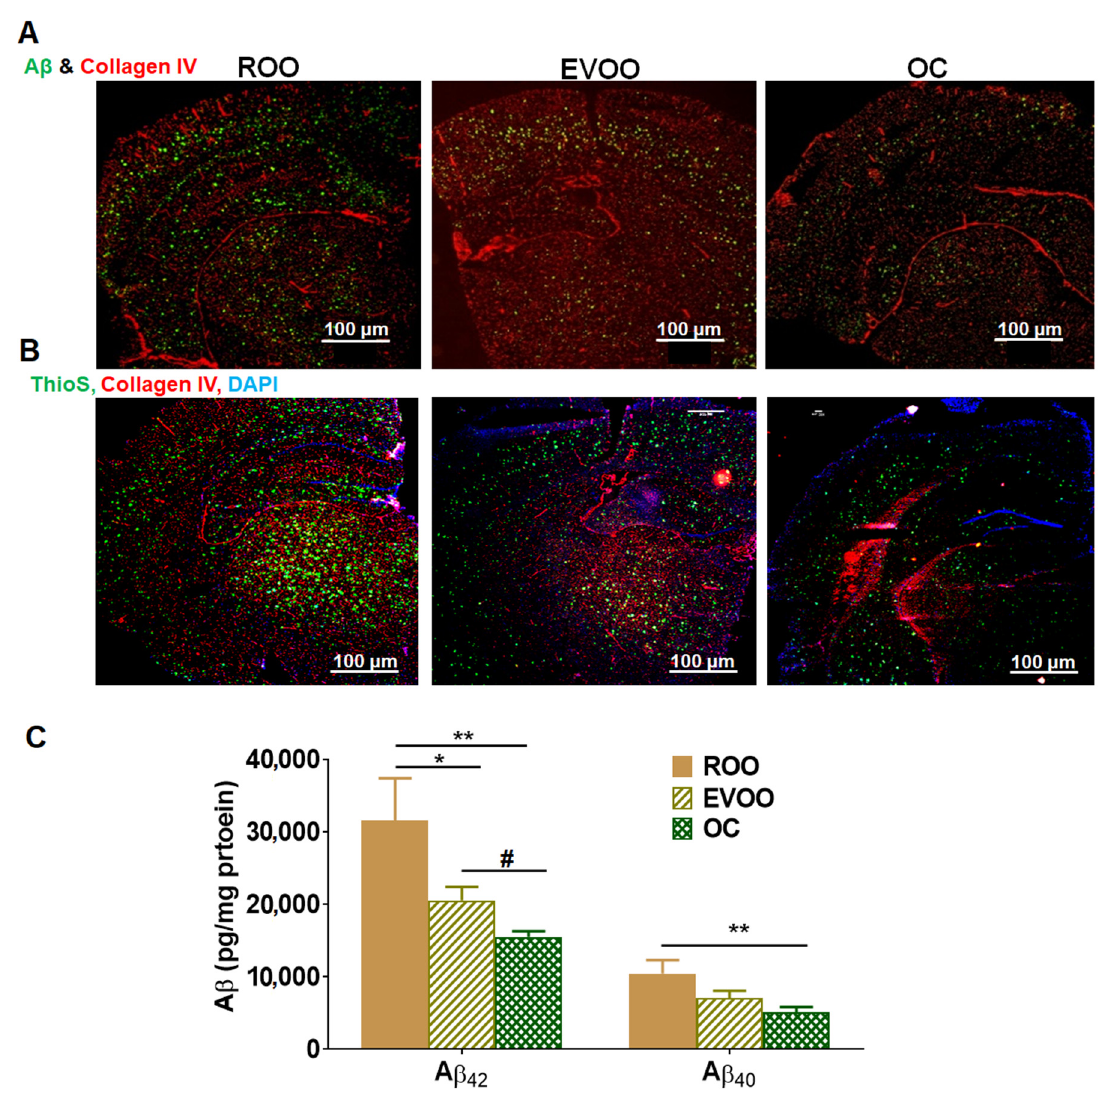
Figure 1. Effect of EVOO and OC consumption (0.5 µ g/kg) for three months on A β burden in 5xFAD mouse brains. ( A ) Representative brain sections stained with 6E10 antibody to detect total A β load and anti-collagen IV antibody to detect microvessels. ( B ) Representative brain sections stained with ThioS to detect A β plaques, anti-collagen IV antibody to detect microvessels, and DAPI (blue). Scale bar, 100 µ m. ( C ) Brain levels of both soluble human A β 40 and A β 42 levels were determined by ELISA. Data represented as mean ± SEM (n = 8 mice per group). * p < 0.05, ** p < 0.01 compared to ROO; # p < 0.05 compared to